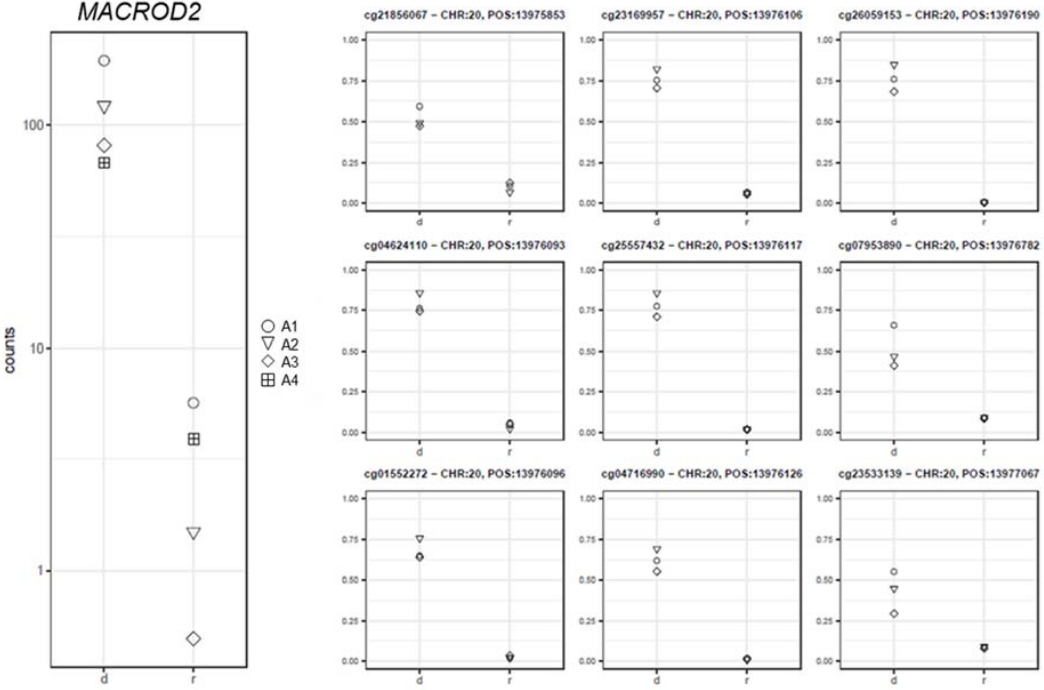
Figure 8. Gene expression (left panel) and corresponding methylation level (right panel) comparison between the samples at diagnosis (d) and remission (r) for the MACROD2 gene.